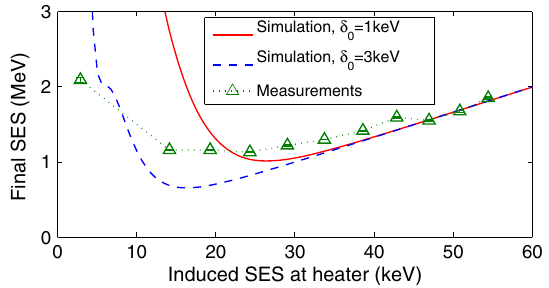
FIG. 21. Final energy spread as a function of laser-heater induced energy spread for the 1 kA working point. The analytical calculation is shown for a Gaussian spread (before the heater) of 1 keV (red, solid) and 3 keV (blue, dashed). The green triangles show the XTCAV